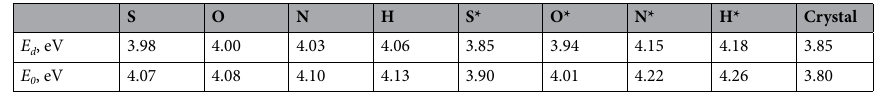
Table 1. The bandgap ( E d ) and critical-point ( E 0 ) energies in different STO films and crystal.